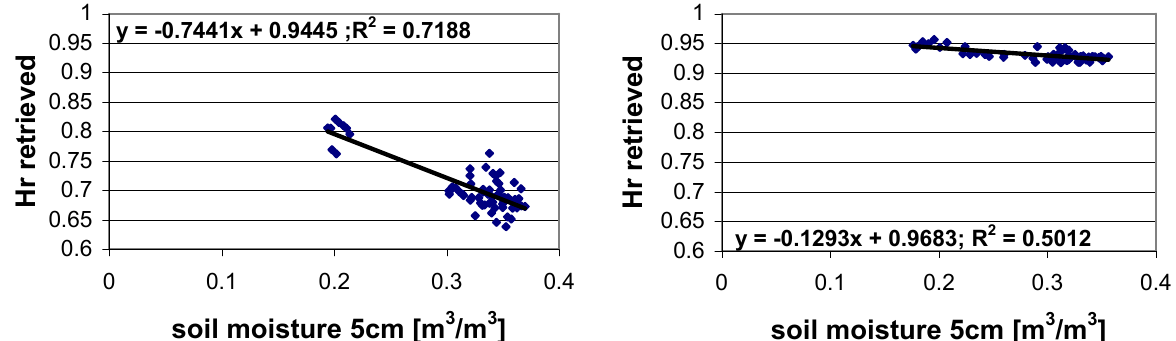
Figure 12. Correlation between measured soil moisture and retrieved roughness parameter for early (left) and late (right) growing period. H r y = -0.7441x + 0.9445 ;R 2 =